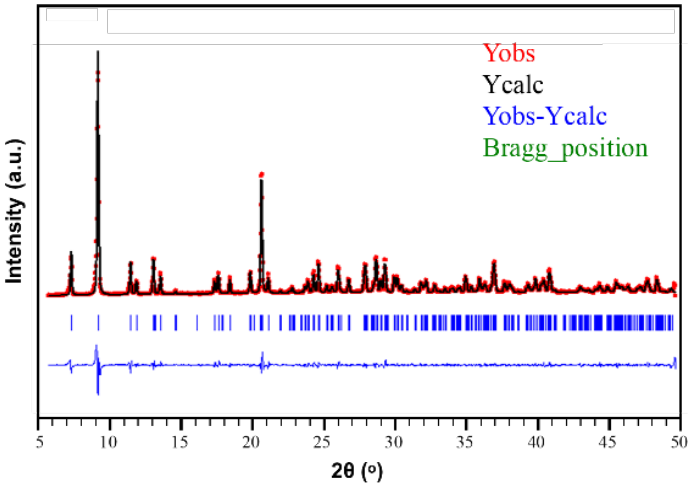
Figure 1. Figure of the pattern matching analysis and experimental PXRD for compound 1 .